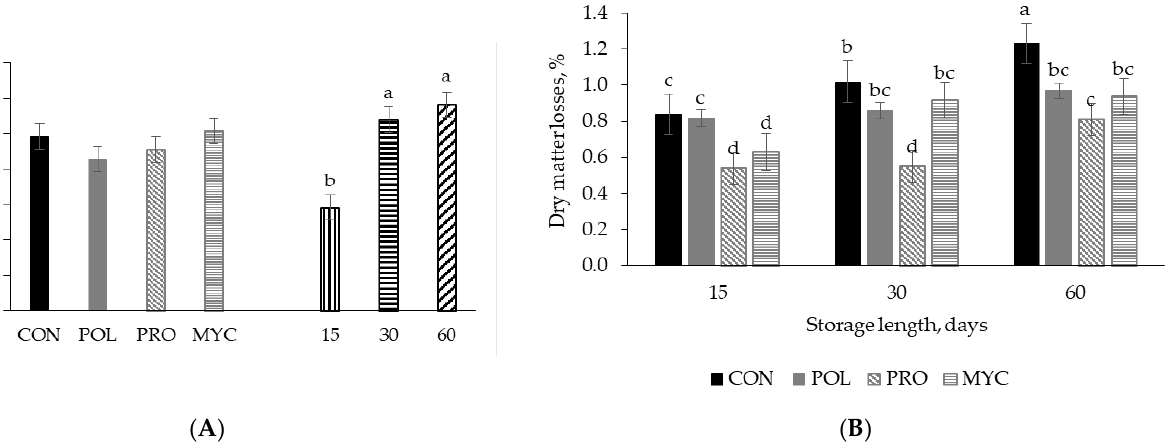
Figure 5. Aerobic stability and dry matter losses of reconstituted corn grain silage ensiled for 15, 30 or 60 d, without additives treatment (CON), or treated with polysorbate 80 (POL), propionic acid (PRO) or polysorbate 80 and propionic acid (MYC). Statistical effects observed for ( A ) Aerobic stability–Additive, p = 0.10, SEM = 2.35; Storage, p < 0.01, SEM = 2.04; A × S, p = 0.42; ( B ) Dry matter losses–Additive, p < 0.01; Storage, p < 0.01; A × S, p < 0.01; SEM = 0.04. Different letters differ by Tukey’s test ( p ≤ 0.05).